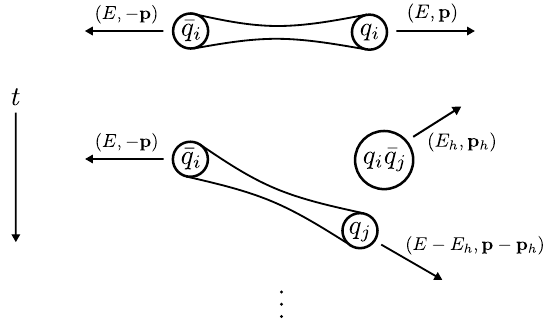
Figure 1: Schematic of a single fragmentation event, for an initial quark–anti-quark pair, q ¯ q , into a hadron with quarks q i i